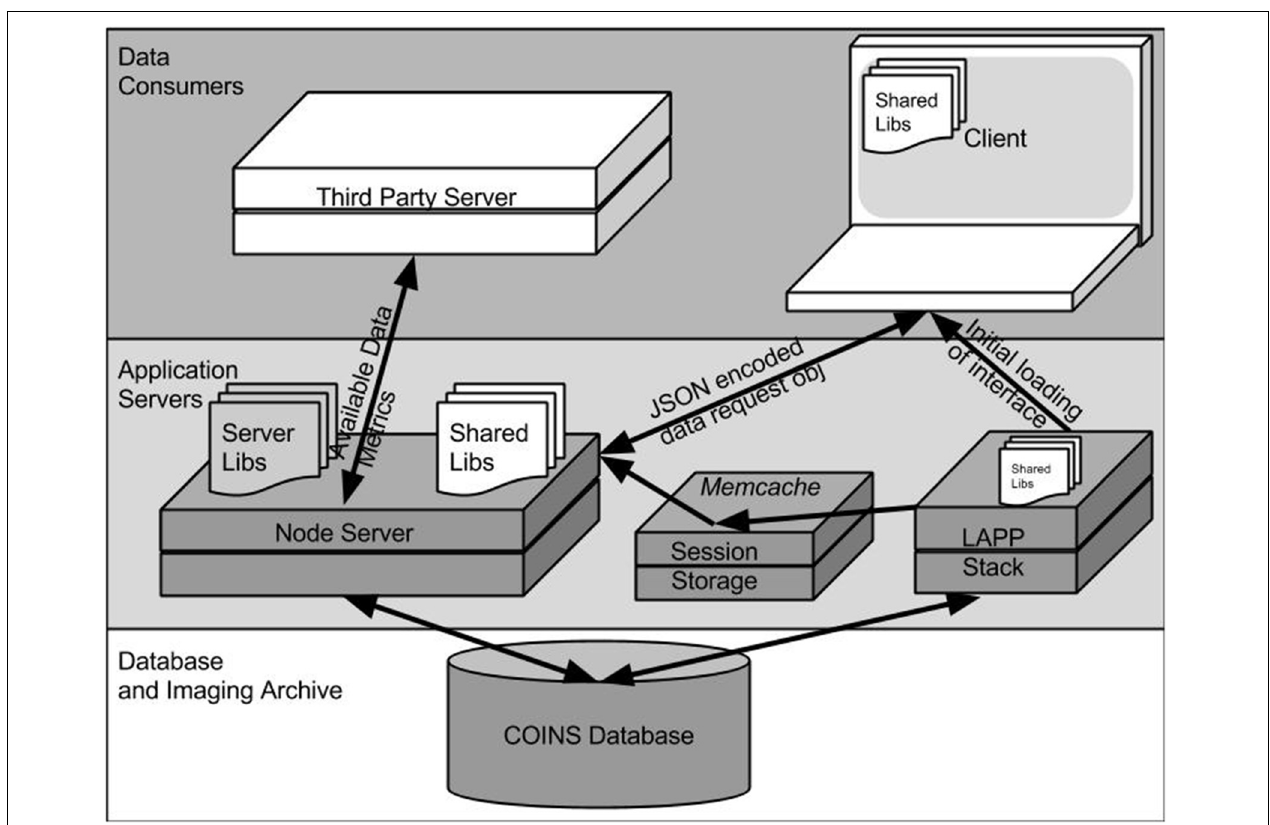
FIGURE 2 | COINS DX